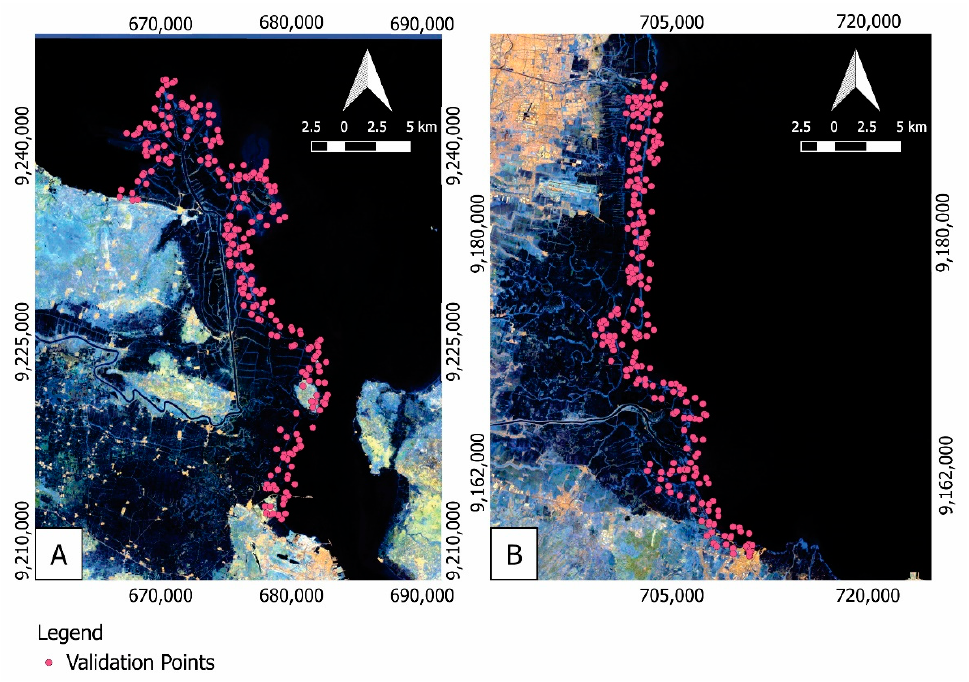
Figure 2. Randomly distributed sample points along the 1 km buffer areas of the ( A ) Gresik and ( B ) Sidoarjo shorelines, used in the accuracy assessment of the GMO maximum entropy (GMO-Maxent) and random forest (RF) methods.